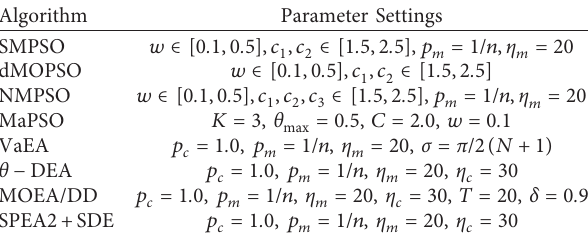
Table 1: General experimental parameter settings. Algorithm Parameter